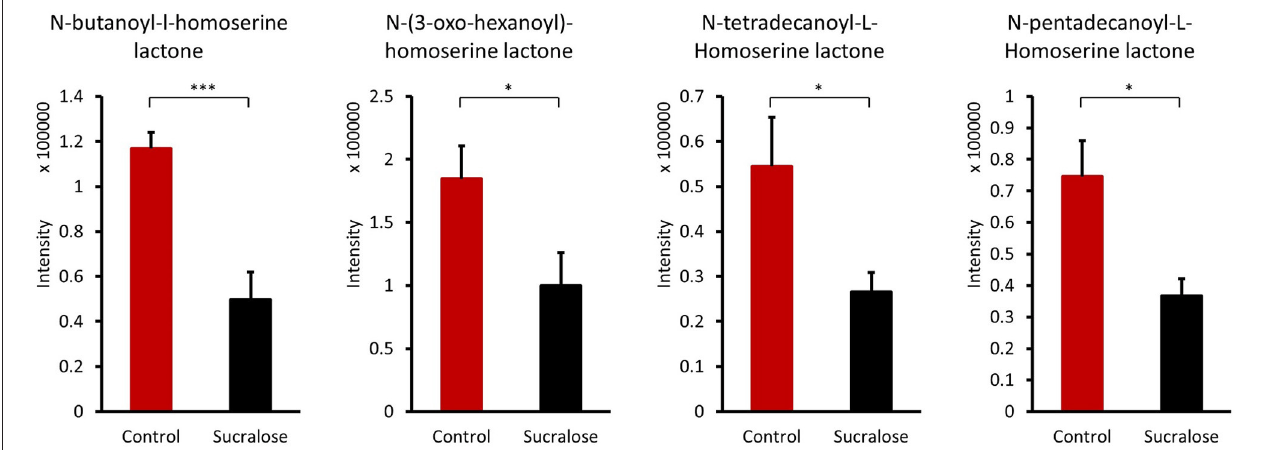
FIGURE 5 | Amino acids and derivatives altered by sucralose. * p < 0.05, ** p < 0.01, *** p < 0.001) (A) tryptophan metabolites; (B) tyrosine metabolites.